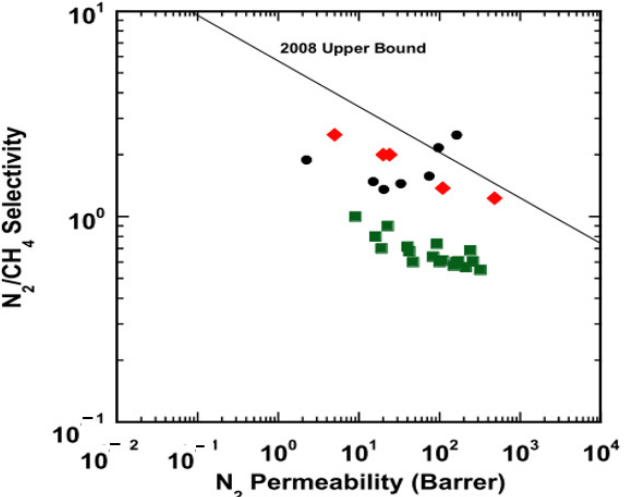
54 of 63 ), PIMs ( Figure 16. N 2 /CH 4 separation performance for TR polymers ( ● ), PIMs ( ■ ), Perfluoropolymers ( ◆ ) ), Perfluoropolymers